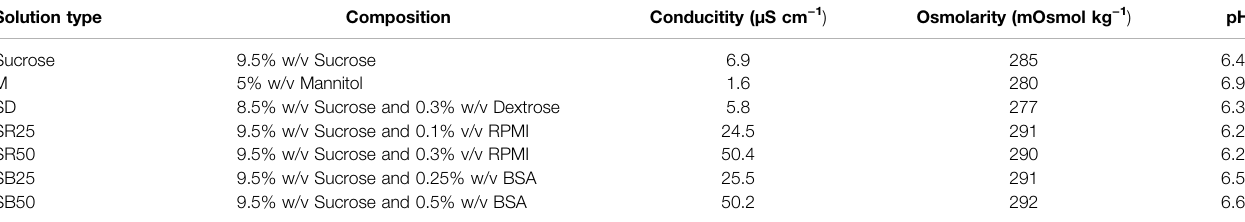
TABLE 1 | The composition and properties of the background solutions prepared for this study. Solution